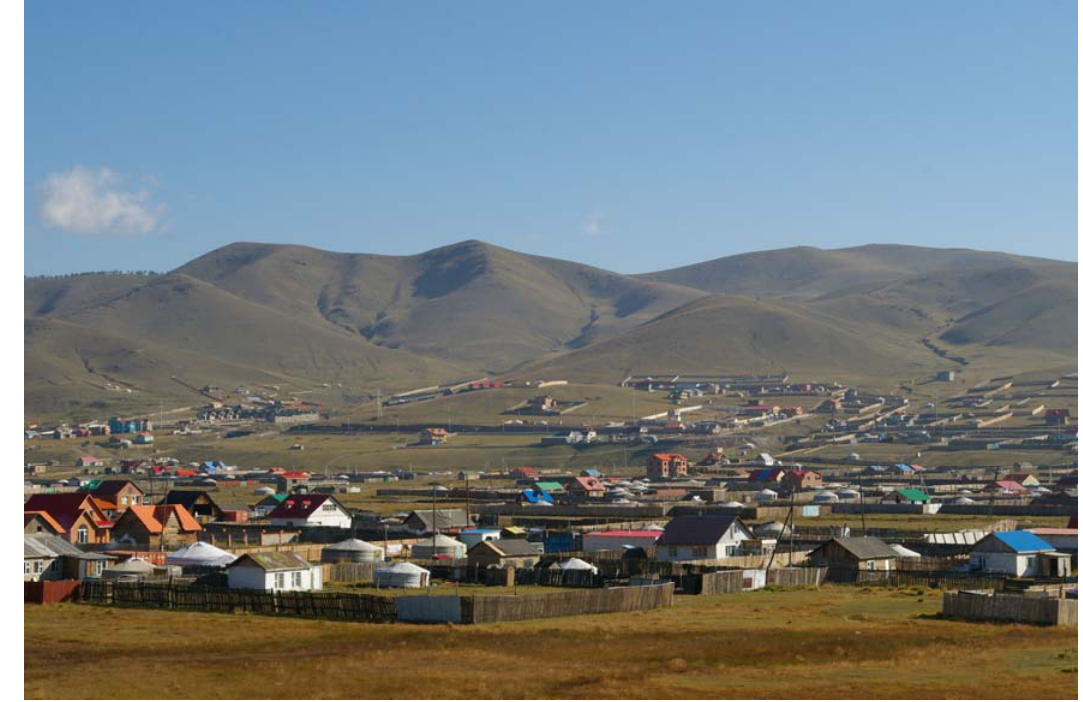
Figure 1. Residential plots surrounded by khashaas in the